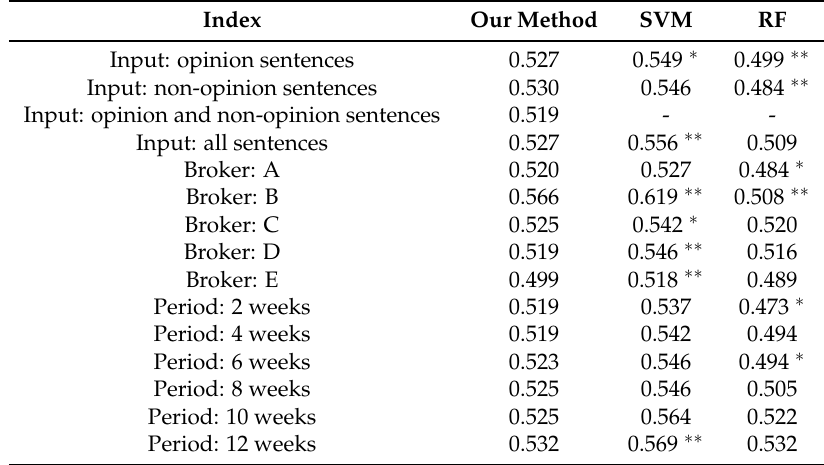
Table 8. Summary of forecasting excess returns. Macro-F1 is a measure. The scores of SVM and RF in the row of input: opinion and non-opinion sentences are indicated by hyphens (-) because SVM and RF cannot have separates inputs for opinion and non-opinion sentences.